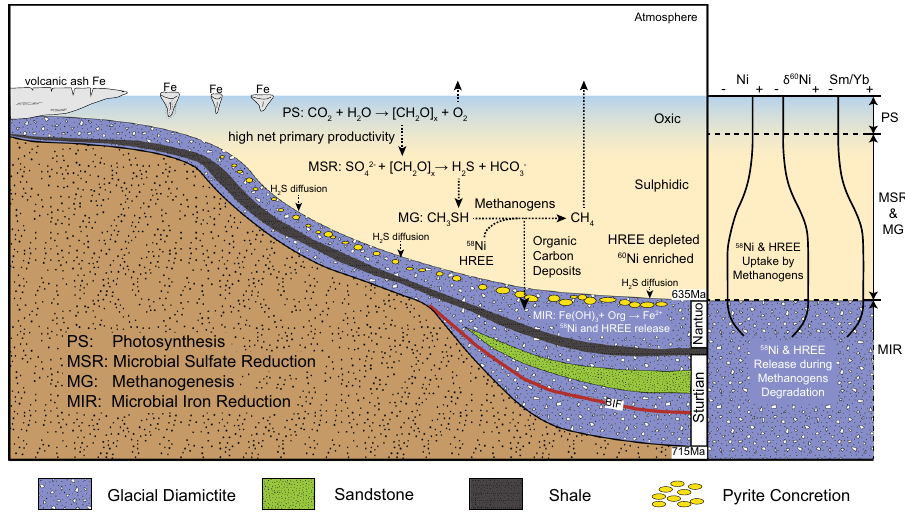
Fig. 7 Schematic model showing the biogeochemical cycles during the termination of Marinoan snowball Earth in the Yangtze Block. The recovery of primary productivity provided abundant organic matter in the euphotic zone by photosynthesis (PS), fueling microbial sulfate reduction (MSR) in the water column. Seawater MSR sustained sul fi dic condition. 7 Active methanogenesis (MG) might be fueled by methyl sul fi de that was produced by H 2 S- methylation in sul fi dic seawater. Since methanogens preferentially absorb light Ni and heavy rare earth element (HREE), seawater was characterized by higher δ 60 Ni and displayed a HREE-depleted pattern. Sinking of particulate biomass of methanogens into sediments sustained microbial iron reduction (MIR), which converted ferric Fe (Fe 3 + ) to Fe 2 + , and released absorbed light Ni and HREE in porewater. Syndepositional pyrite precipitation in sediment porewater would incorporate both seawater and porewater signals, and various degree of degradation of methanogen-derived organic matter led to a negative correlation between Ni concentration and δ 60